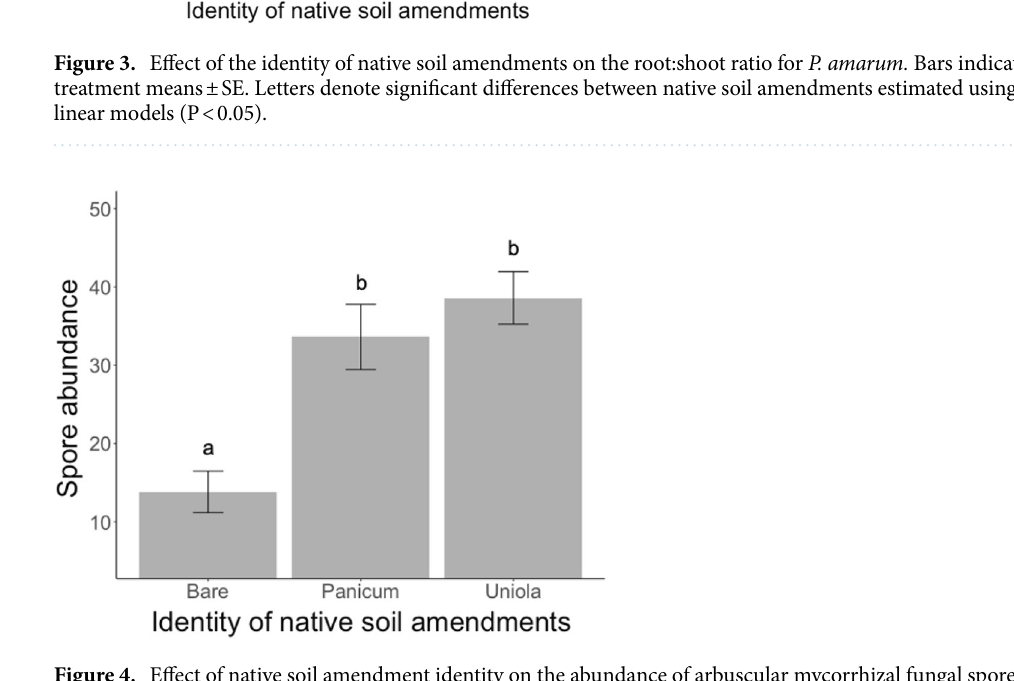
Figure 4. Effect of native soil amendment identity on the abundance of arbuscular mycorrhizal fungal spores. Spores were extracted from 25 ml of soil. Bars indicate treatment means ± SE. Letters denote significant differences between native soil amendments estimated using linear mixed-effects models (P <